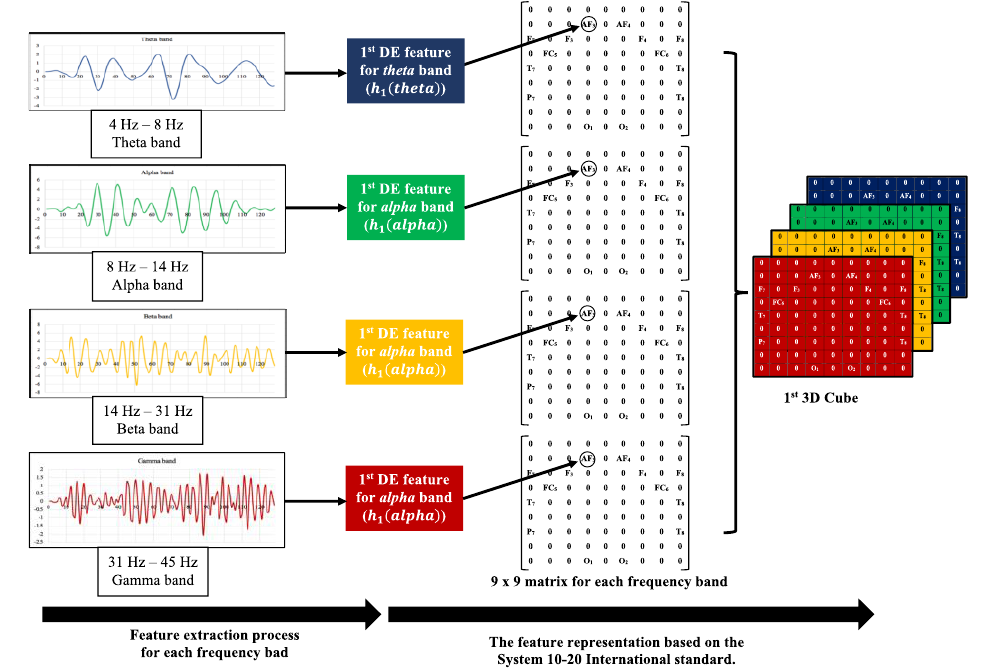
Figure 3. Feature extraction and representation processes for AF3 in the DREAMER dataset